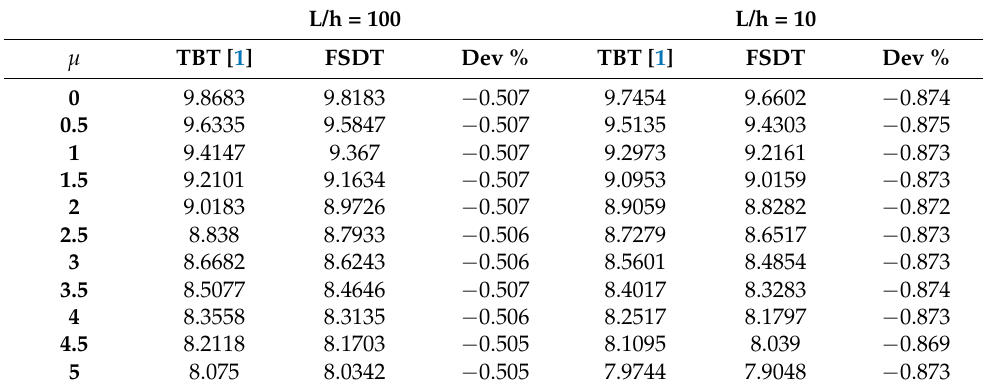
Table 2. Nondimensional fundamental frequencies ( Ω adim ) in SS homogeneous beams. L/h = 100 L/h = 10 TBT